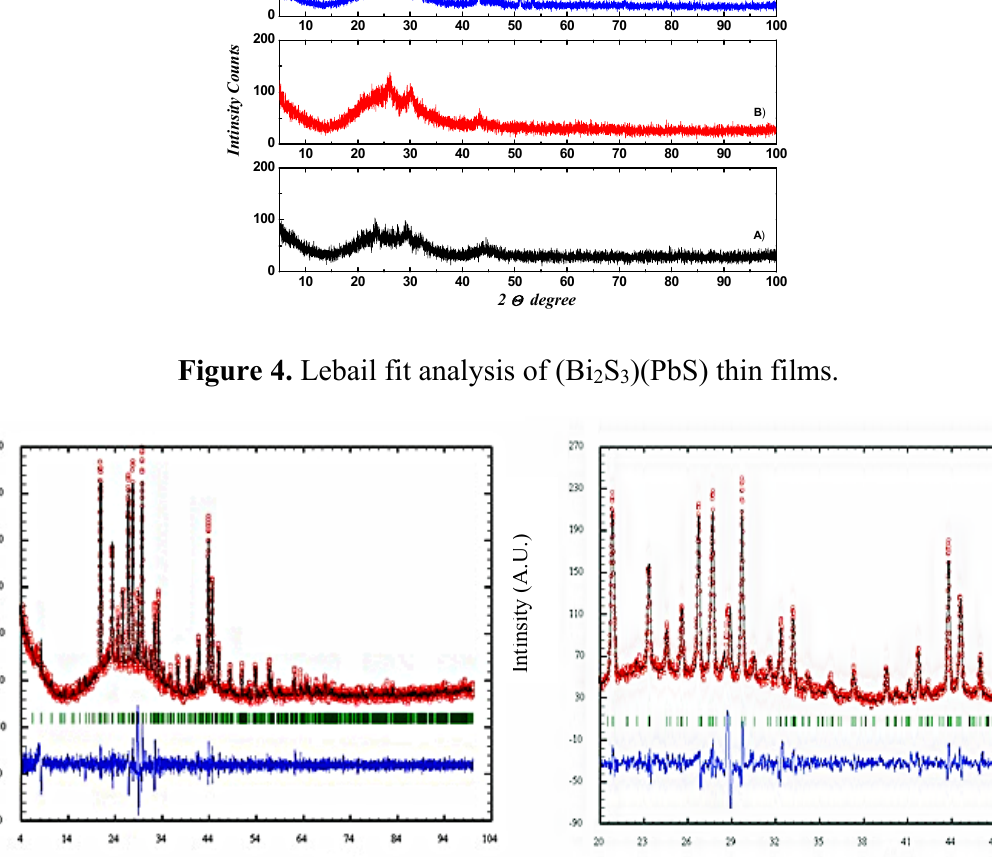
Figure 3. XRD of (Bi 1 h; and ( C ) Annealed at 698 K for 4 h.